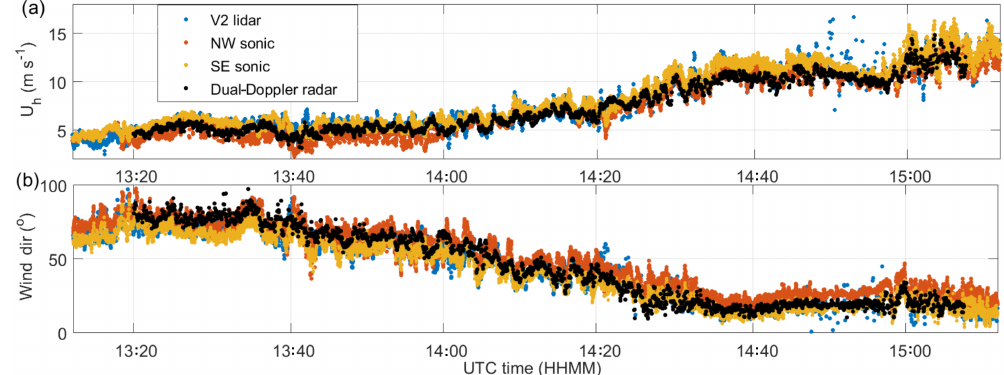
Figure 4. Dual-Doppler radar measurements at 150m height compared with sonic anemometer and V2 lidar data: (a) horizontal wind speed U h (ms − 1 ) ; (b) wind direction ( ◦ ). The date of the observation is 25 March 2015.